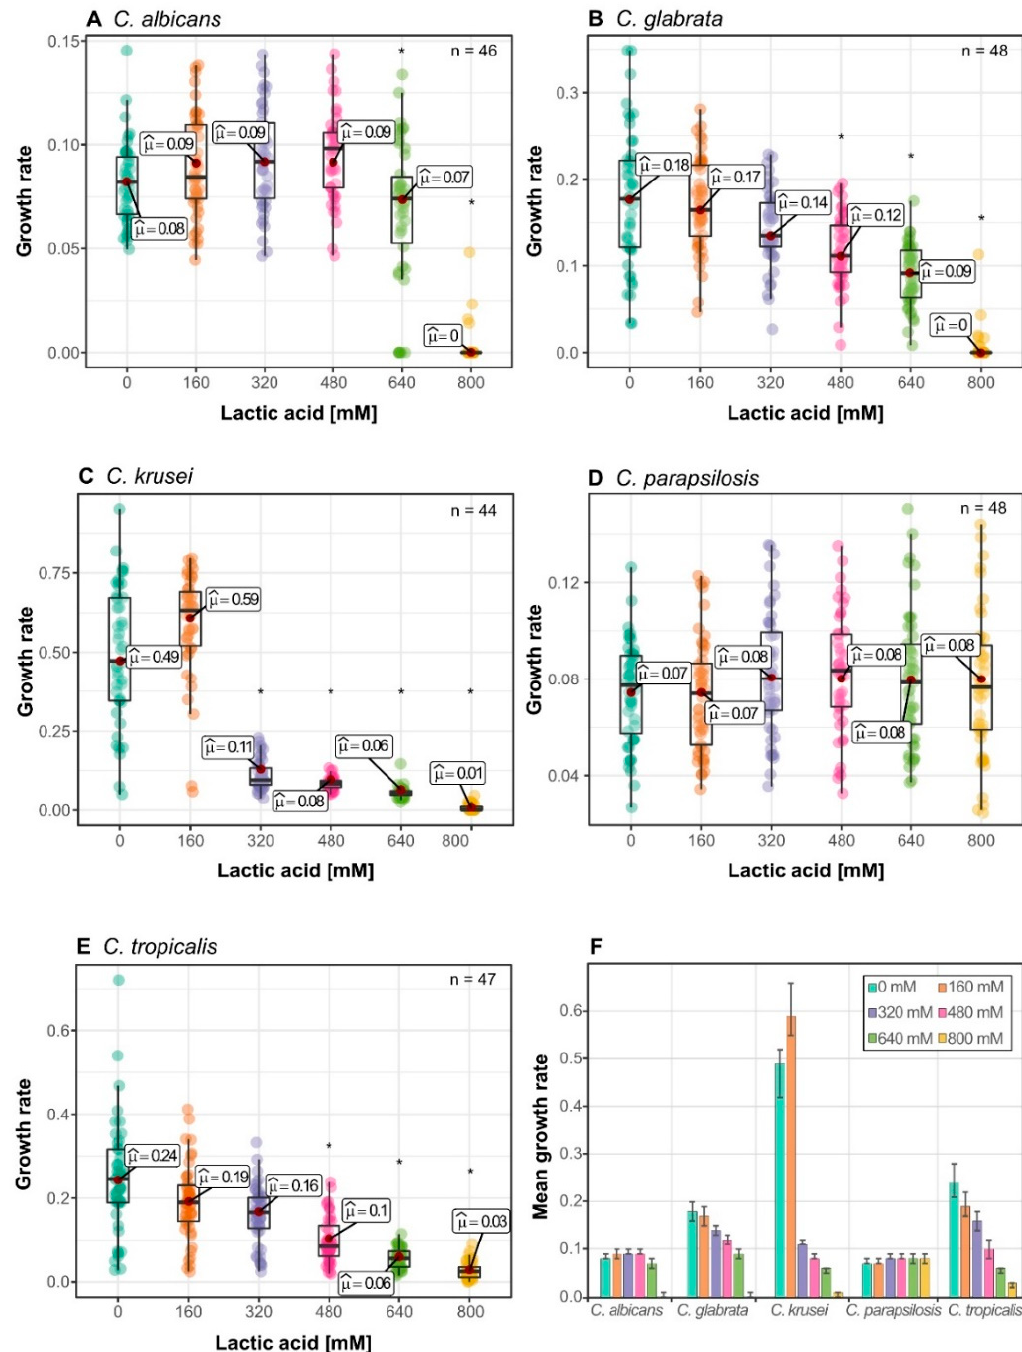
Figure 4. Lactic acid tolerance of Candida species using glycerol as carbon source Growth response to lactic acid stress with 2% Glycerol as carbon source; ( A ) C. albicans ; ( B ) C. glabrata ; ( C ) C. krusei ; ( D ) C. parapsilosis ; ( E ) C. tropicalis ; ( F ) Mean growth rates of di ff erent Candida species to lactic acid stress, error bars represent confidence interval of 95%; Each data point represents mean growth rate of triplicates measurements; Asterisks represents statistical di ff erence of one condition to the next lower lactic acid concentration (* p ≤ 0.001). Raw data can be found in Supplementary Table